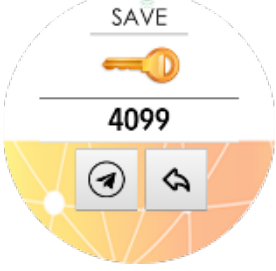
Figure 6. SAVE configuration app.